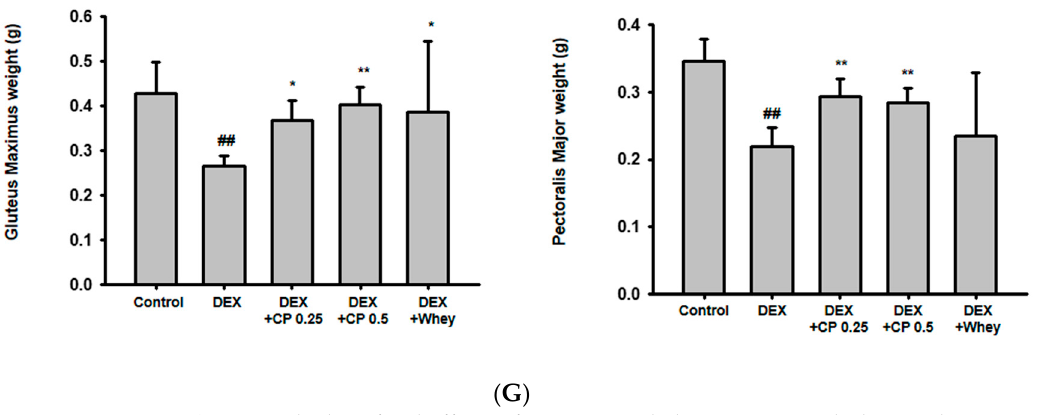
Figure 1. The beneficial effects of CP on muscle loss in mice with dexamethasone (DEX)-induced muscle wasting. ( A ) Experimental scheme to induce muscle atrophy and orally administer CP. ( B ) Micro-computed tomography (CT) images of calf muscles obtained after 4 weeks of CP intake. The muscles in red are shown as two-dimensional transverse section images. F and T represent the fibula and tibia, respectively. ( C – F ) The calf muscle volume in each region ( C ) was measured and presented in ( D – F ). ( G ) The weight of the gluteus maximus and pectoralis major, which were obtained and weighed after 4 weeks of CP intake. Whey protein (1 g/kg) was employed as a positive control. The data in ( D – G ) are expressed as the means ± SD. This experiment was performed with ten mice per group. ## p < 0.01, DEX vs. control. * p < 0.05, ** p < 0.01, DEX + CP (0.25 and 0.5) vs. DEX; CP, collagen peptides; DEX, dexamethasone; F, fibula; T, tibia.